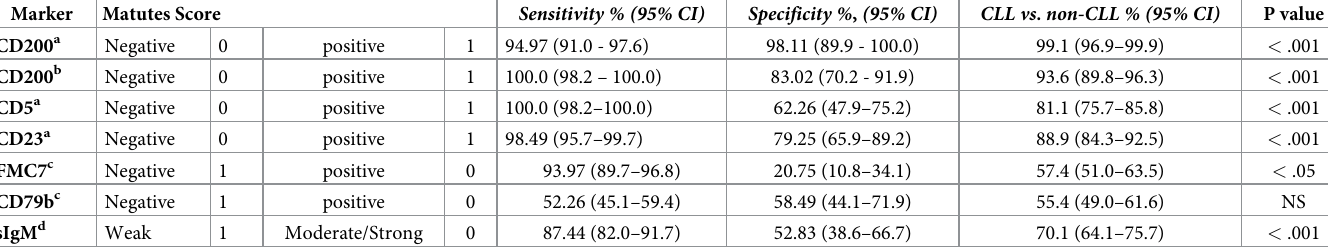
Table 3. Sensitivity, specificity, and accuracy of individual markers in the differential diagnosis of